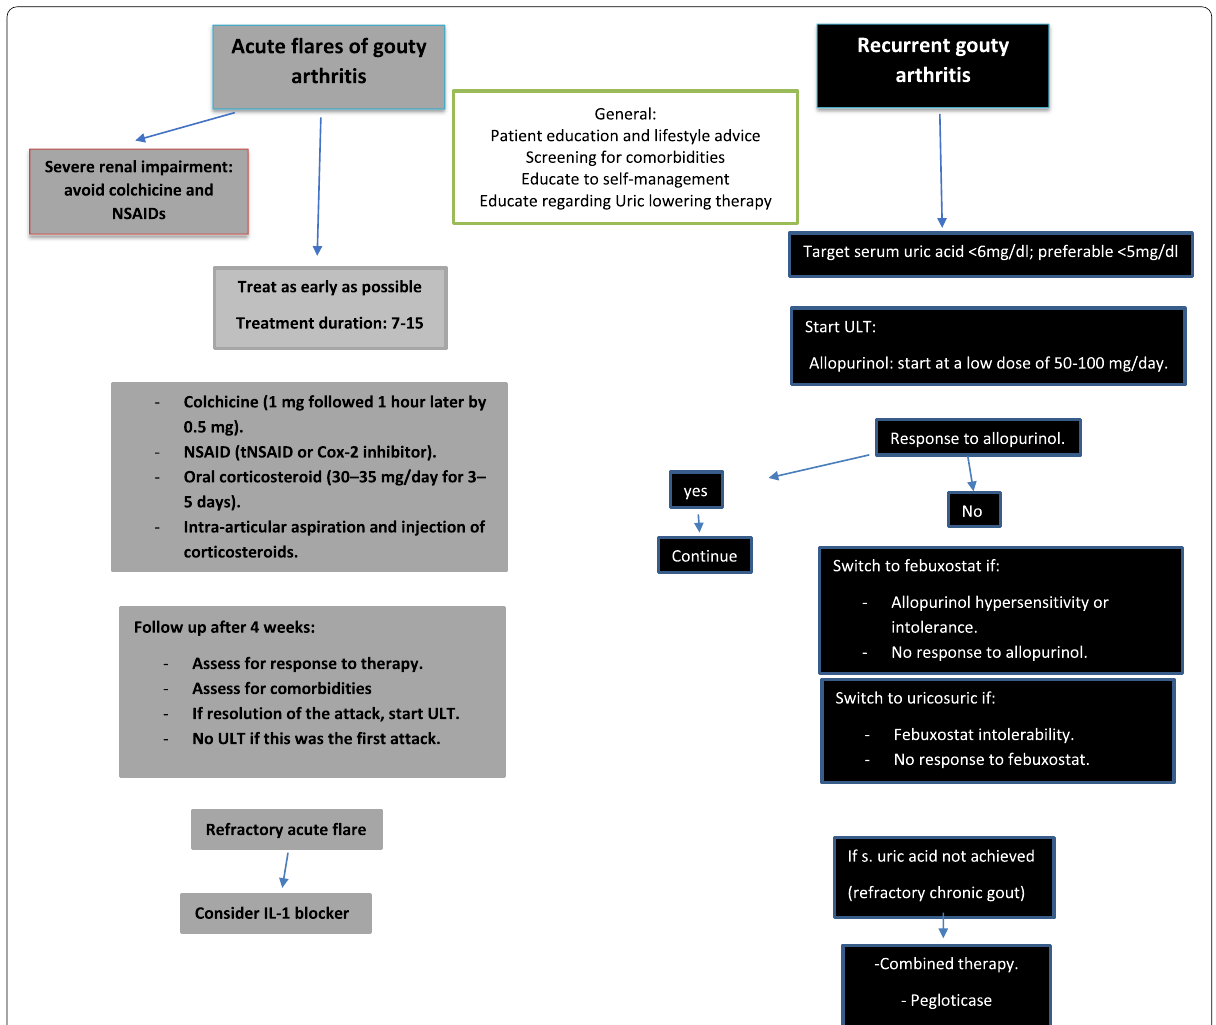
Fig. 2 Algorithm for the management of acute and recurrent